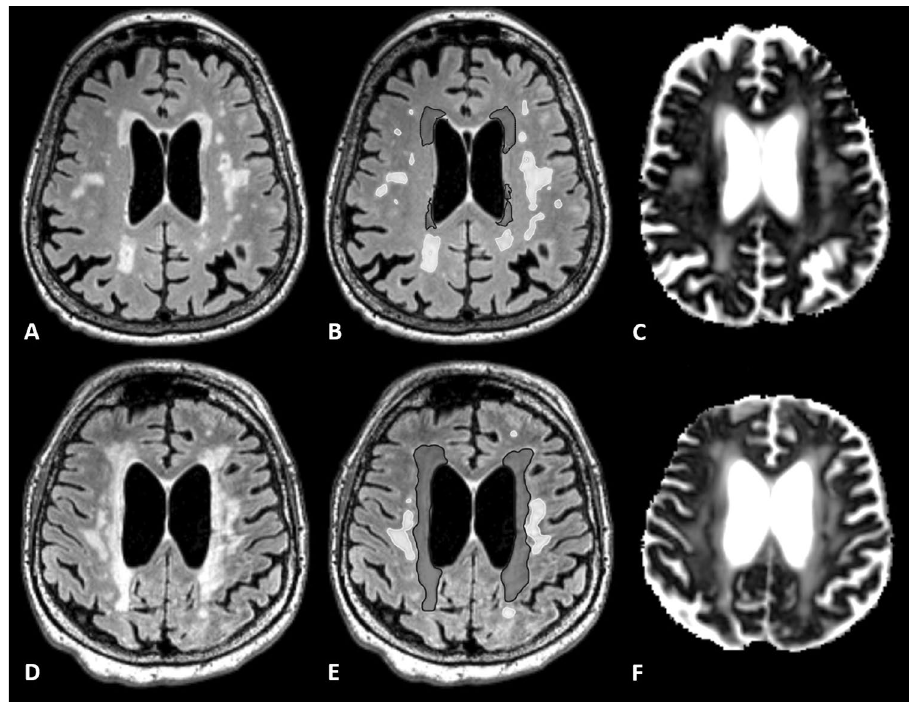
Figure 4. Axial FLAIR reformats in patients without ( A ) and with imaging features of iNPH ( D ) with corresponding superimposed segmentations ( B , E) divided into periventricular hyperintensities (dark grey) and deep white matter lesions (light grey). Related parametric V-CSF-maps are shown in ( C ) and ( F